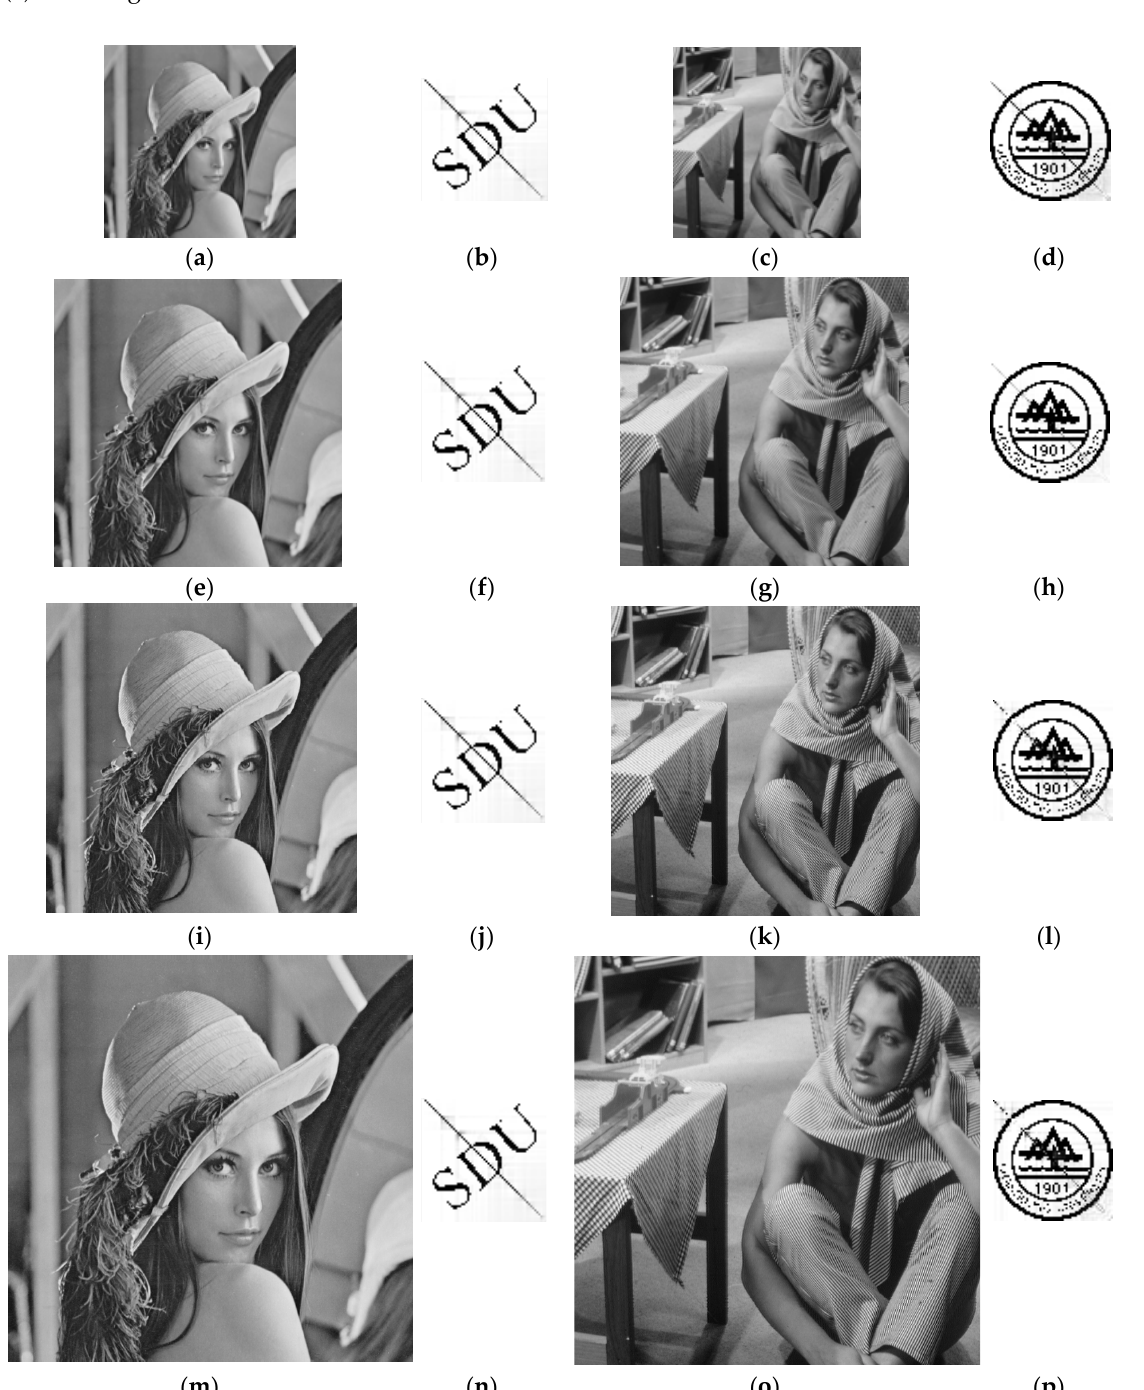
Figure 17. Watermarked images and extracted watermarks under scaling attacks: ( a ) scaled Lena (0.25); ( b ) extracted watermark w 1 ; ( c ) scaled Barbara (0.25); ( d ) extracted watermark w 2 ; ( e ) scaled Lena (0.5); ( f ) extracted watermark w 1 ; ( g ) scaled Barbara (0.5); ( h ) extracted watermark w 2 ; ( i ) scaled Lena (0.9); ( j ) extracted watermark w 1 ; ( k ) scaled Barbara (0.9); ( l ) extracted watermark w 2 ; ( m ) scaled Lena (1.2); ( n ) extracted watermark w 1 ; ( o ) scaled Barbara (1.2); ( p ) extracted watermark w 2